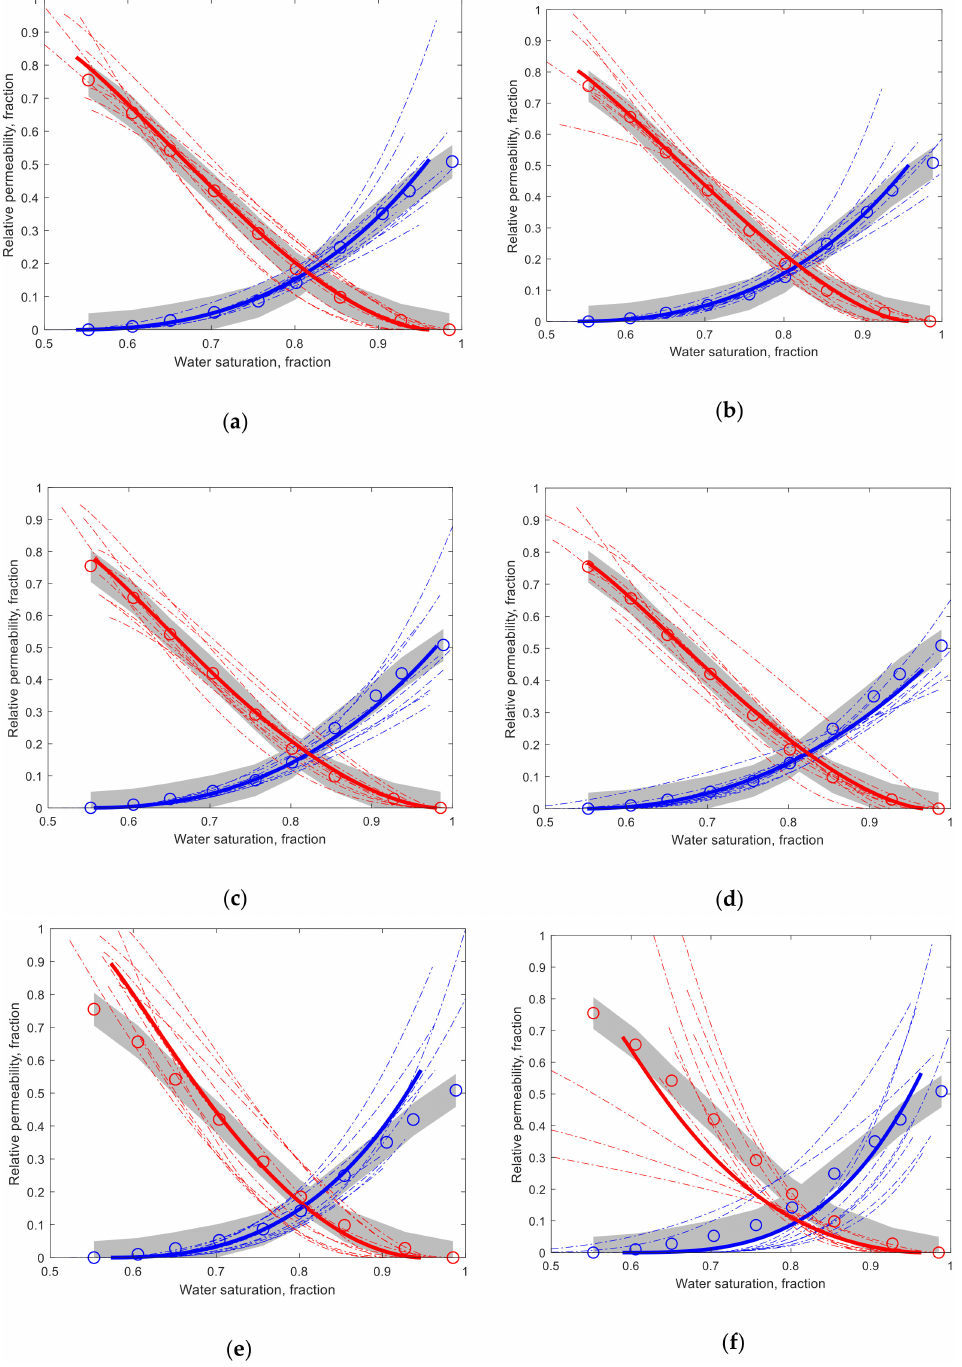
Figure 9. Comparison of interpreted versus true relative permeability curves for the synthetic sample with pressure drops of ( a ) 0.3 MPa, ( b ) 0.25 MPa, ( c ) 0.2 MPa, ( d ) 0.15 MPa, ( e ) 0.1 MPa, and ( f ) 0.05 MPa: Open circles are reference data points (red for gas and blue for water); dashed lines are independent runs; solid lines are averaged values of the independent runs; and gray bands are the ± 5% confidence